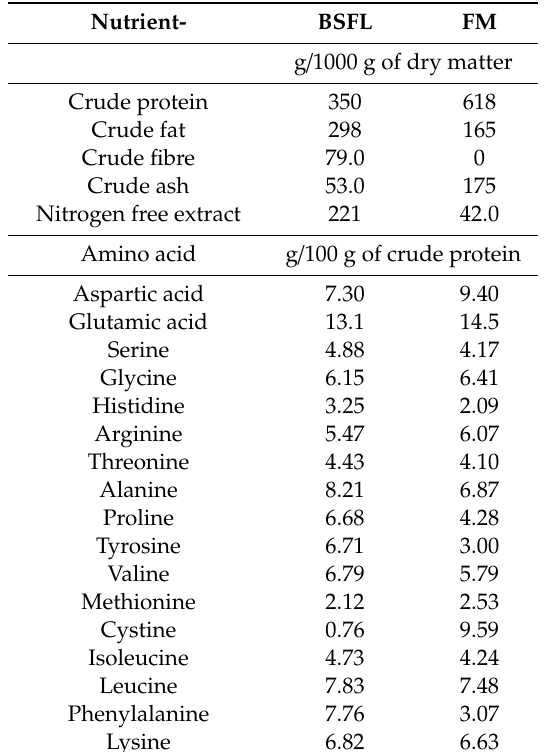
Table 1. Nutritive value and amino acid profile of Black soldier fly full-fat larvae meal (BSFL) and fish meal (FM) used in the